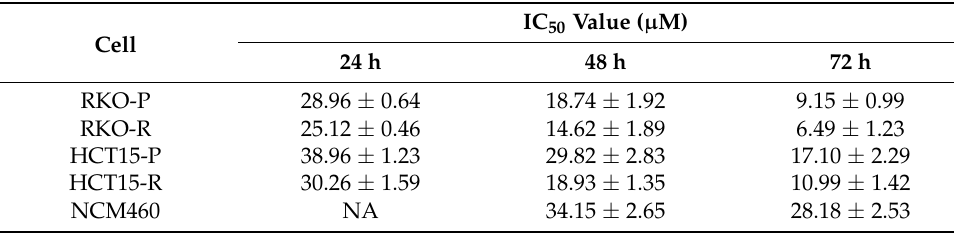
Table 1. The IC50 of AGE on CRC cells and normal